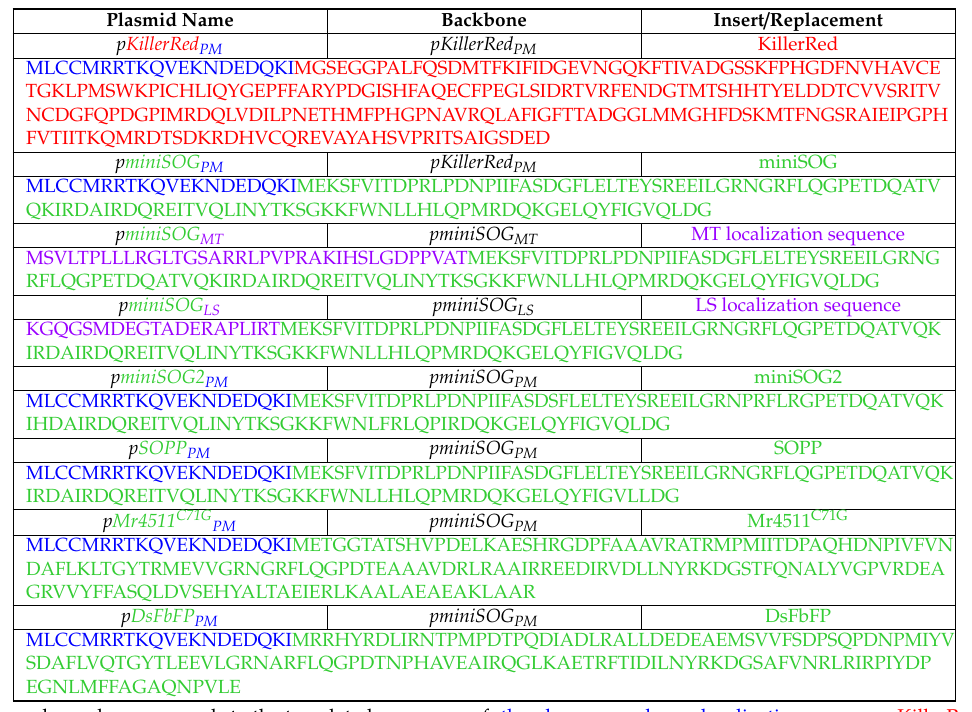
Table A2. Peptide sequence of KillerRed, miniSOG, miniSOG2, SOPP, Mr4511 C71G , and